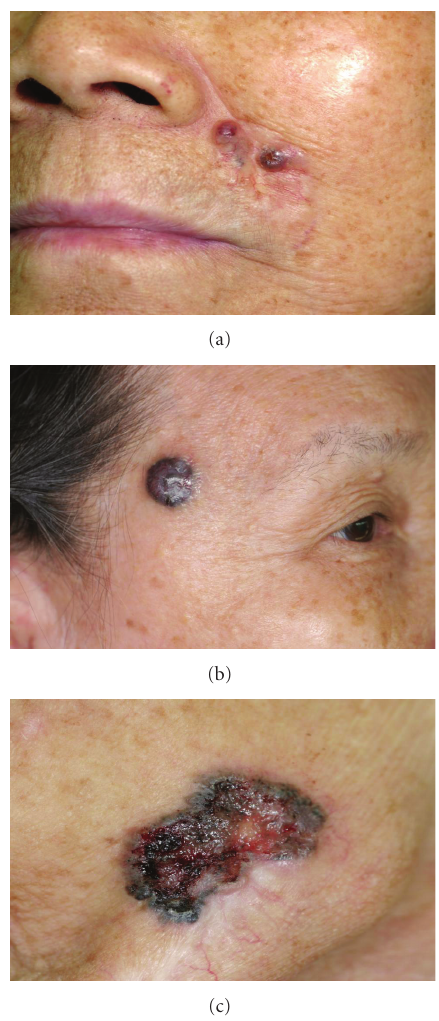
Figure 1: Common presentation of HNBCC in ethnic Chinese: pigmented lesion with well-defined borders, rolled ulcer edges, central pearly area, and overlying